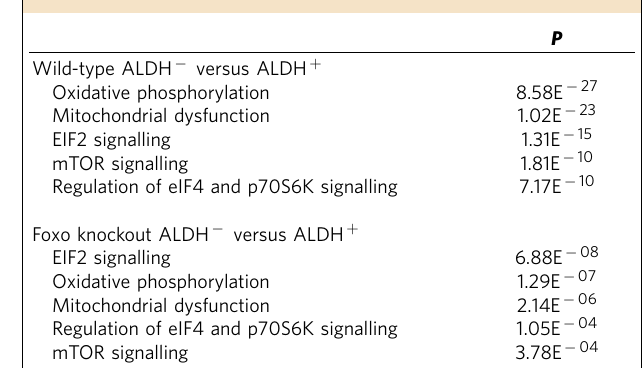
Table 2 | Pathway analysis of RNA sequencing in wild-type and Foxo knockout b cells.